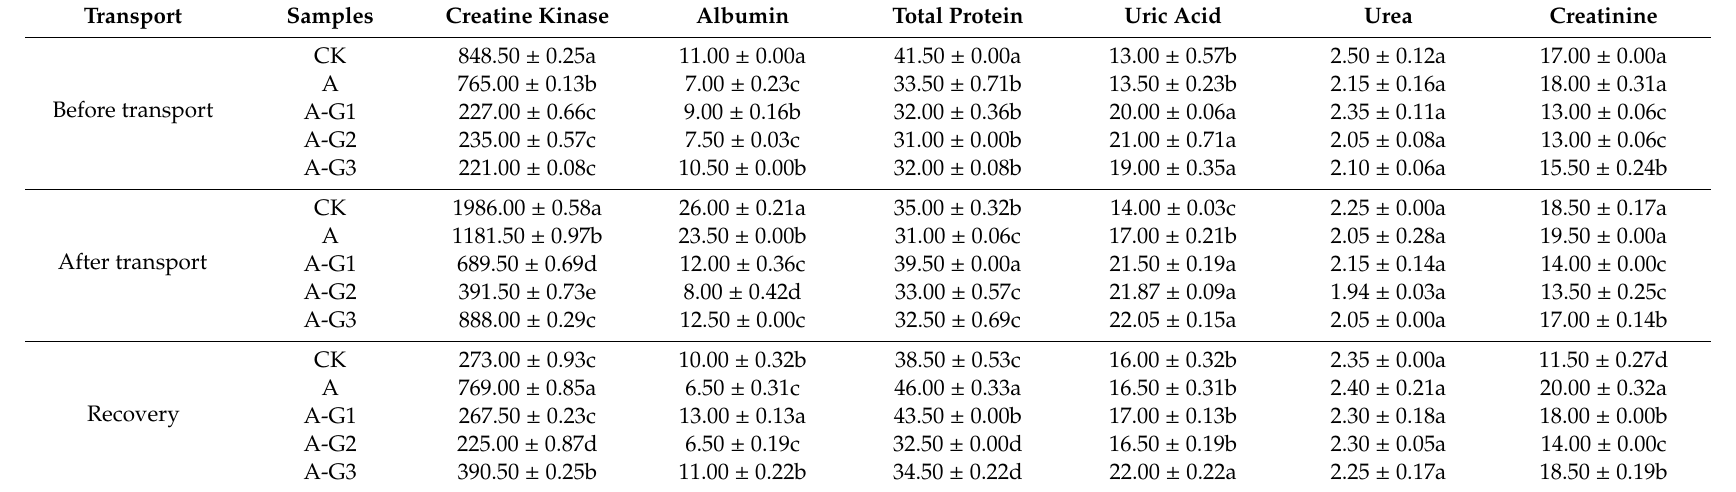
Table 4. E ff ect of ascorbic acid and β -1,3-glucan addition on serum biochemical and physiological of tiger grouper during simulated transport.